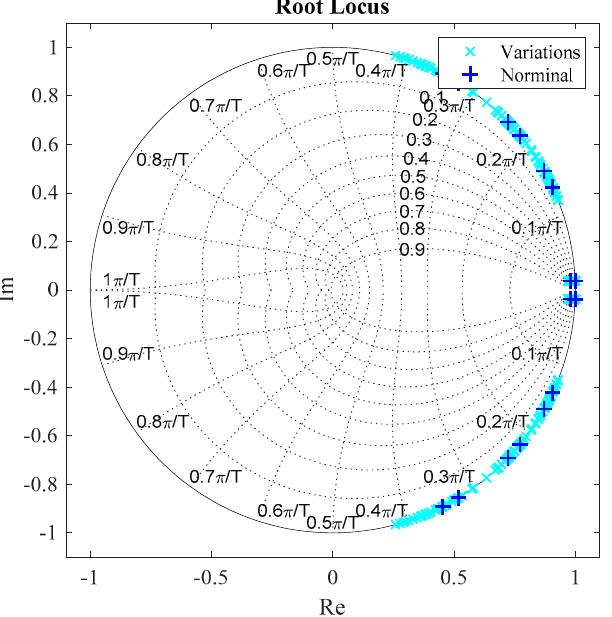
( z ) and its variations. Energies 2020 , 13 , x FOR PEER REVIEW